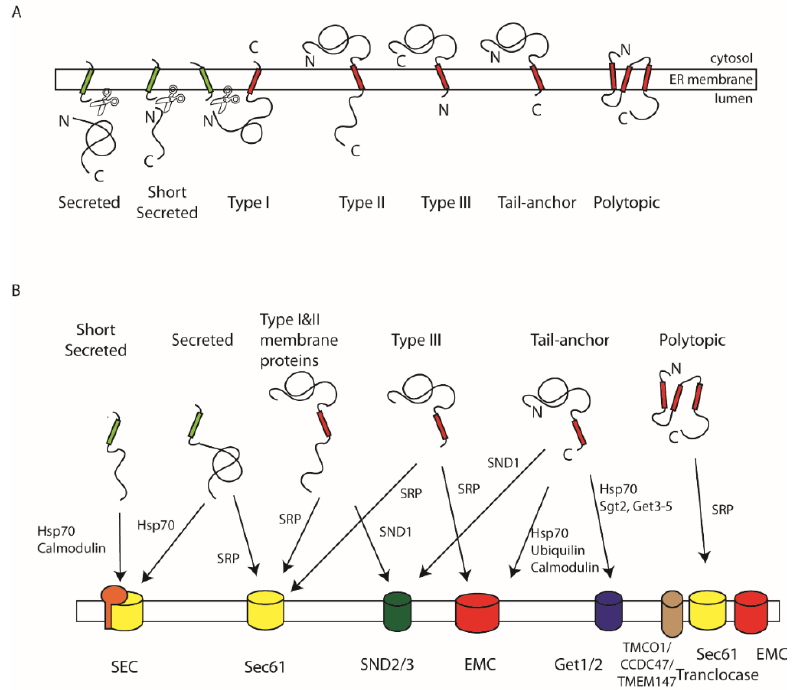
Figure 1. Targeting signals, pathways, and translocases: ( A ) Soluble secretory and luminal proteins as well as type I membrane proteins are targeted by cleavable N-terminally located signal sequences (green). Type II, type III and tail-anchor membrane proteins as well as multi-spanning polytopic membrane proteins utilise internal TM domains (red) for targeting. ( B ) These different classes of secretory and membrane proteins are translocated across or inserted into the membrane by a number of translocases with overlapping specificity. Short secretory proteins are translocated by the SEC translocase and maintained in a translocation-competent state by Hsp70 chaperones or calmodulin. Longer secretory proteins can use the same pathway as well as delivery to the Sec61 translocase by SRP. Type I and II membrane proteins can also be delivered to Sec61 by SRP. Those with more central and C-terminal TM domains can also be targeted by the SND pathway. Type III membrane proteins can be delivered by SRP to either Sec61 or the EMC translocase. Tail-anchored membrane proteins can utilise the SND pathway and the GET pathway as well as delivery to the EMC complex involving Hsp70, calmodulin, or ubiquilins. Finally, polytopic membrane proteins are targeted to the Sec61 translocon by SRP and may recruit the EMC or TMCO1 to assist in their integration.